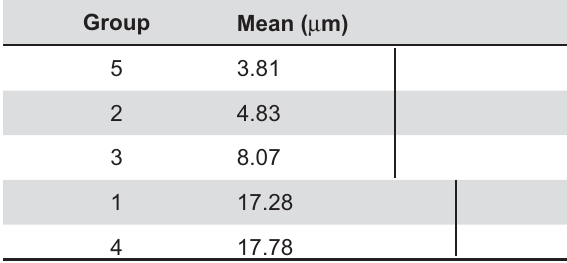
Groups joined by a vertical bar did not present